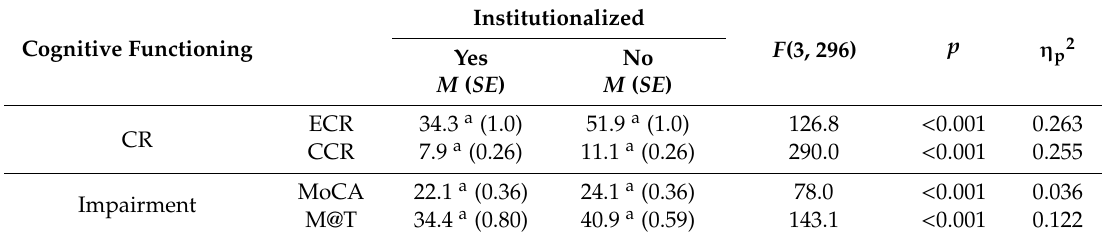
Table 7. Relationship of CR and level of cognitive impairment in institutionalized vs. non-institutionalized people. Means and Standard Deviations corrected according to studies and age (ANCOVA).